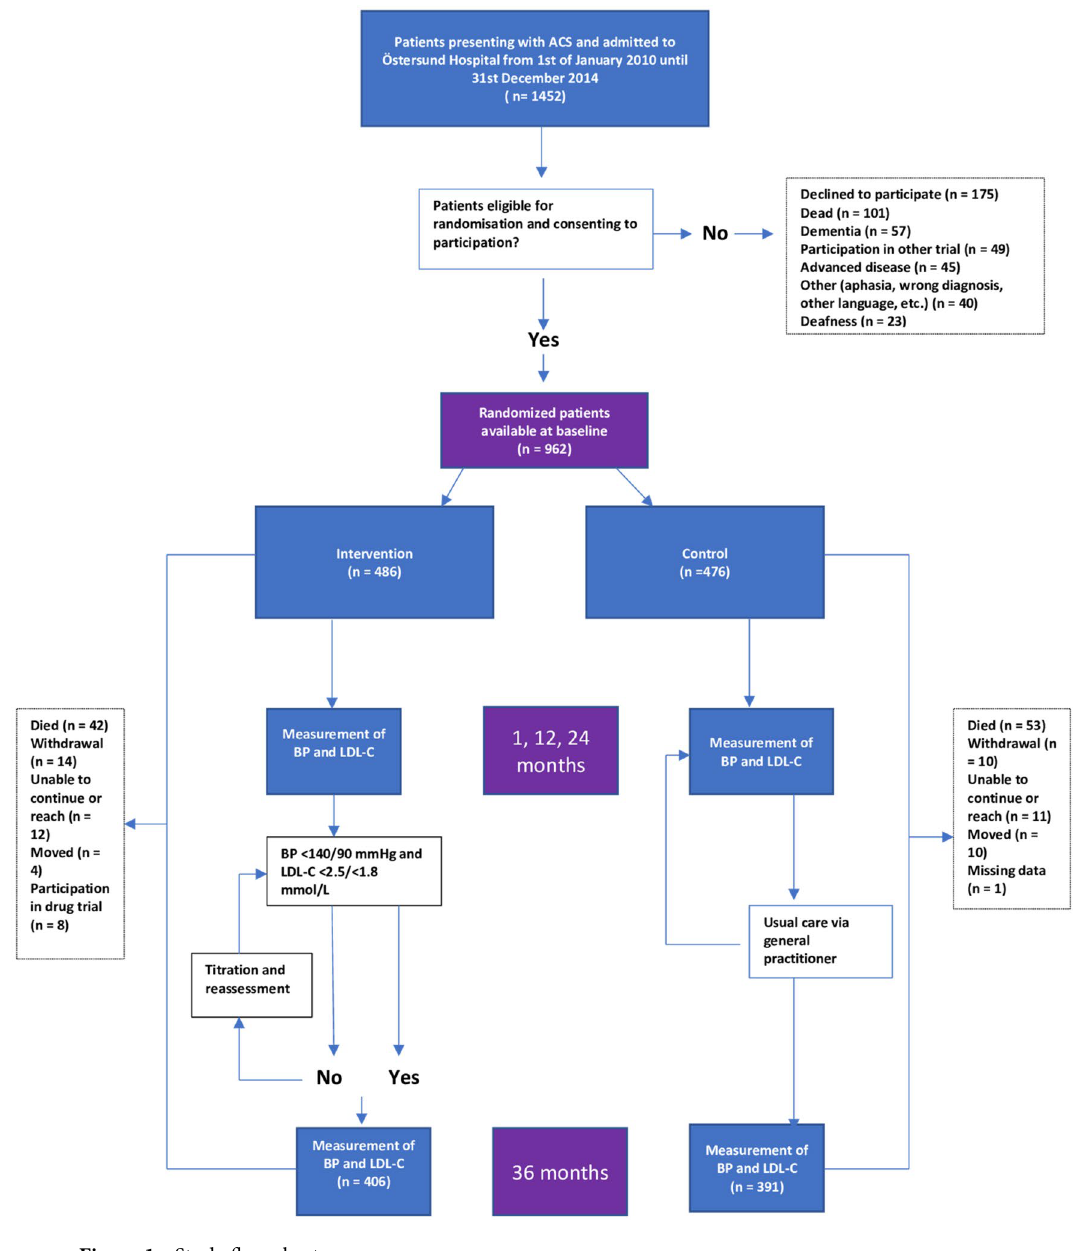
Figure 1. Study flow